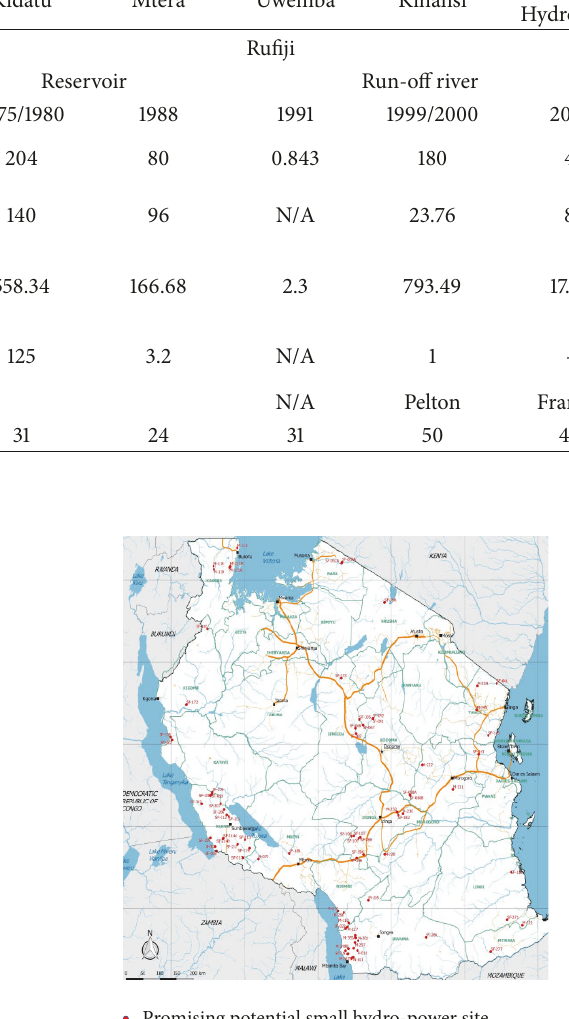
Promising potential small hydro-power site Figure 8: Potential small renewable power sites in Tanzania